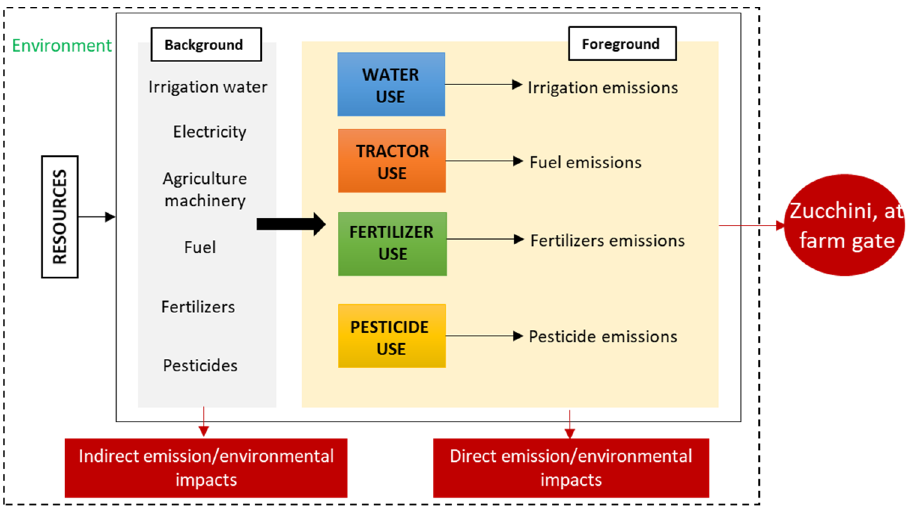
Figure 3. System boundaries for a cradle-to-farm-gate life cycle analysis for zucchini production.